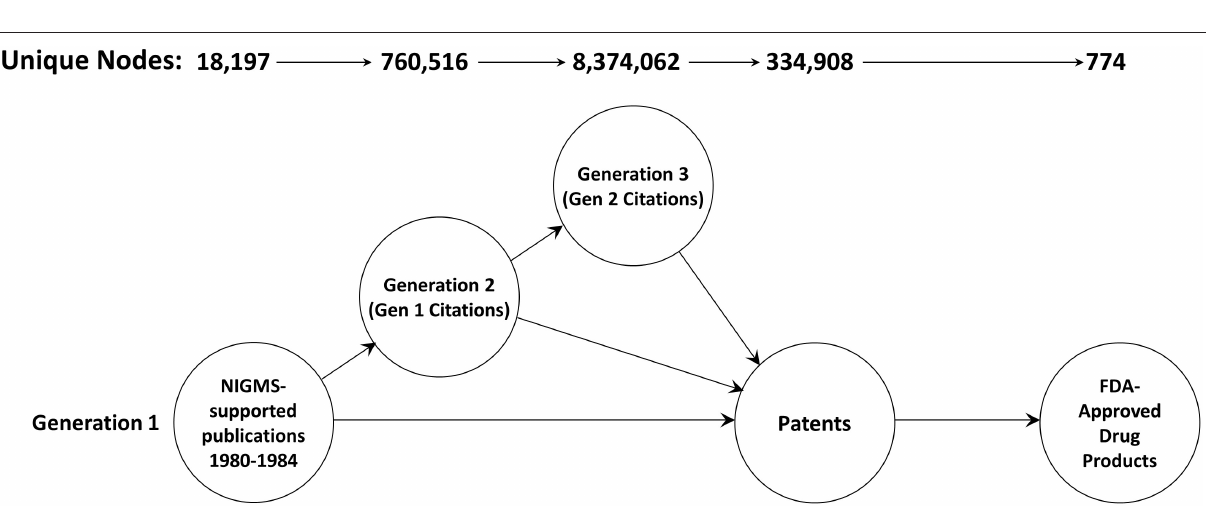
Frontiers in Research Metrics and Analytics |